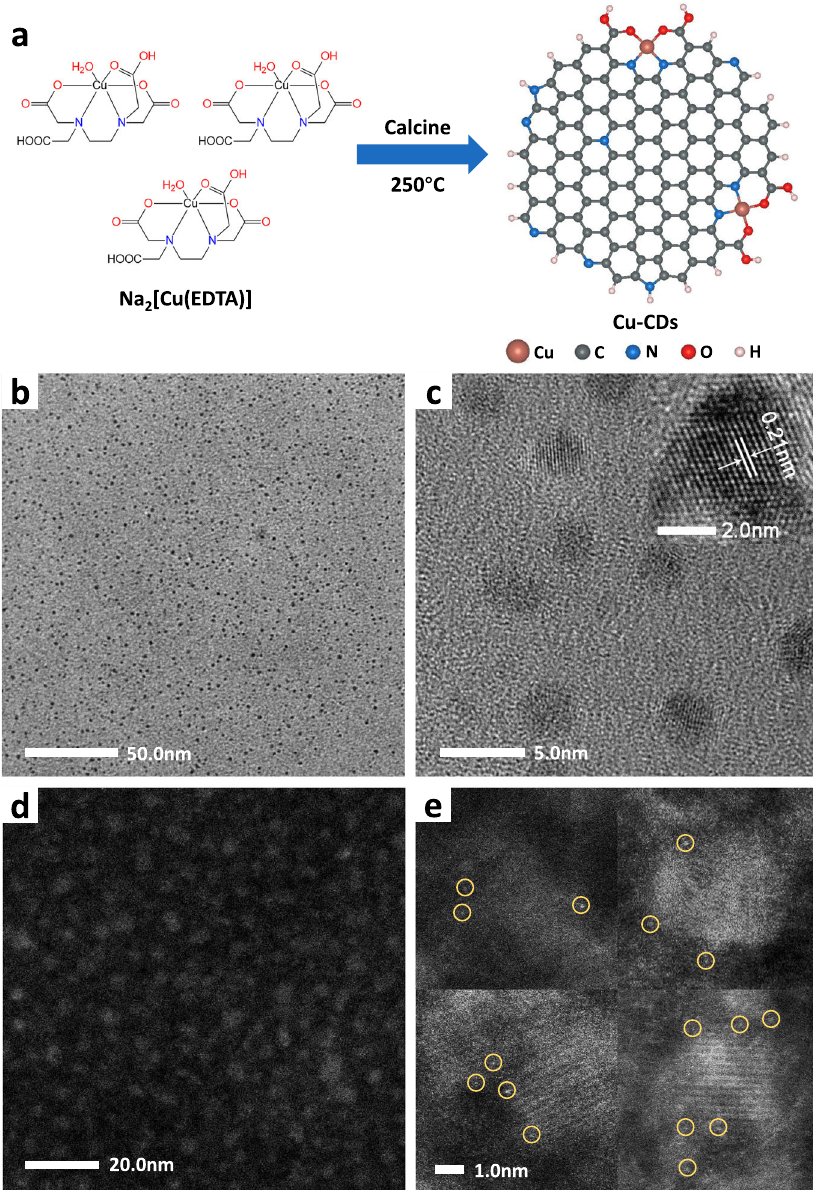
Fig. 1 Morphology characterization of the Cu-CD catalyst. a Scheme of the low-temperature calcining procedure for Cu-CD catalysts. b Large- fi eld of view and c magni fi ed view of TEM images (the inset is the crystal lattice). d Relatively large- fi eld of view and e typical view of HAADF-STEM images of distributed single Cu atoms in carbon dots. Yellow circles in ( e ) indicates typical single Cu